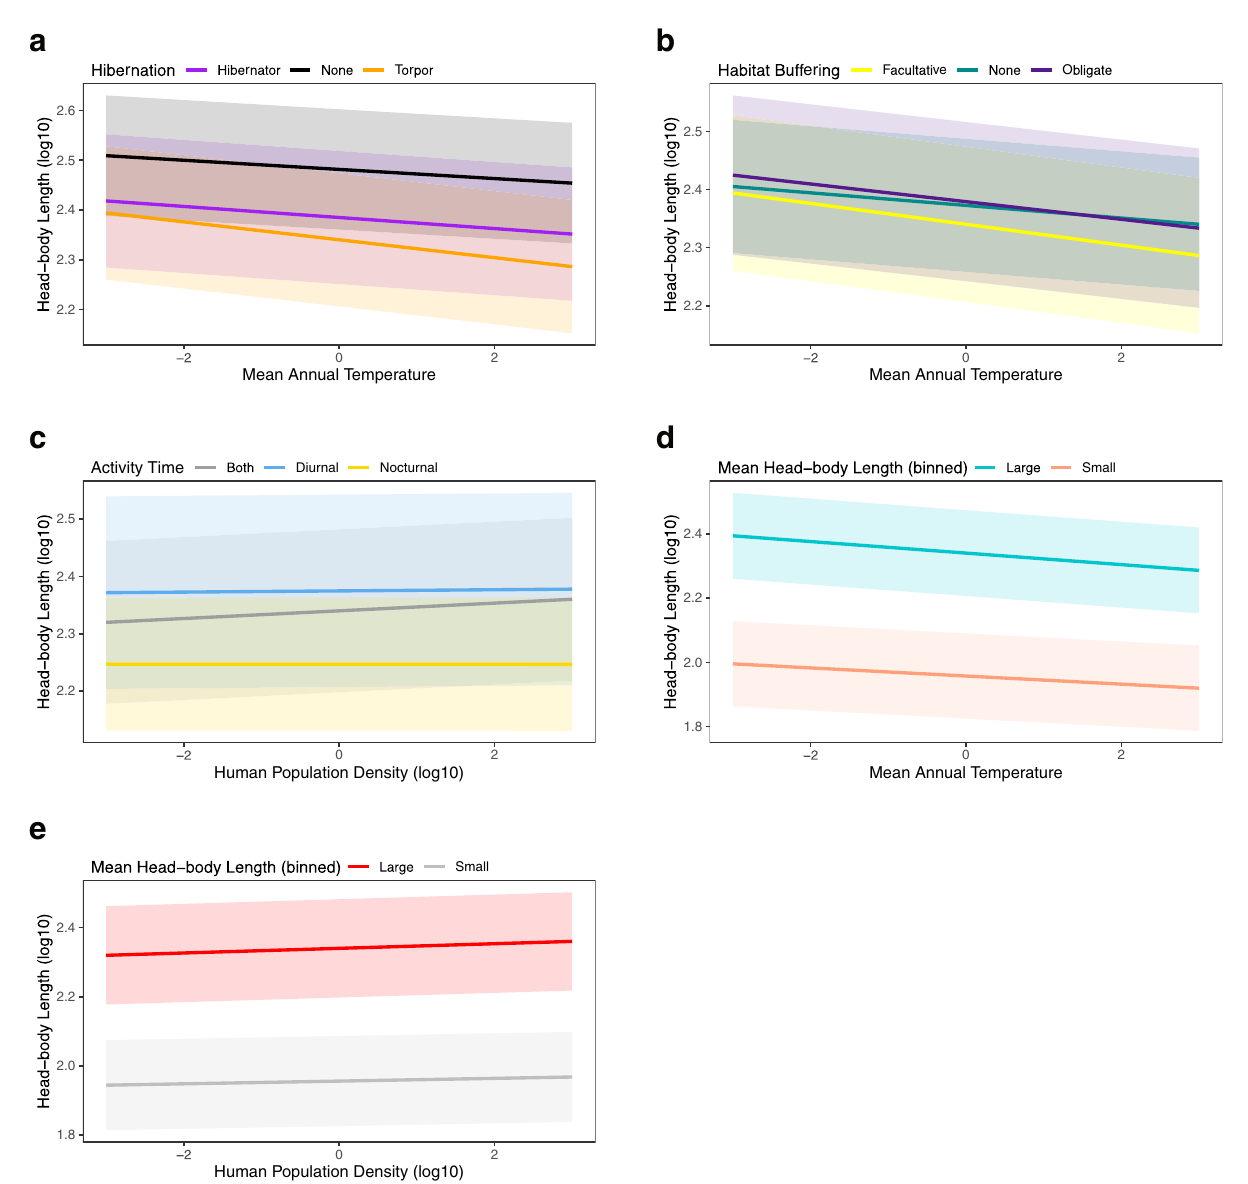
Fig. 3 Mammal head-body length interactions. Mammalian head-body (HB) length is in fl uenced by the interaction between ( a ) hibernation ability and mean annual temperature; ( b ) habitat buffering and mean annual temperature; ( c ) activity time and human population density; ( d ) large/small size and mean annual temperature, and ( e ) large/small size and human population density. Predictor variables (mean annual temperature and human population density) were mean-centered and standardized. Error bars in each plot represent 95% credible